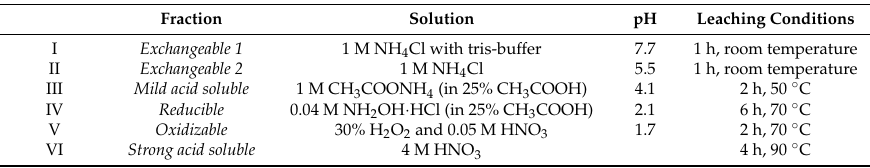
Table 1. Sequential extraction procedure, modified from [16]. The pH values are initial pH values of the